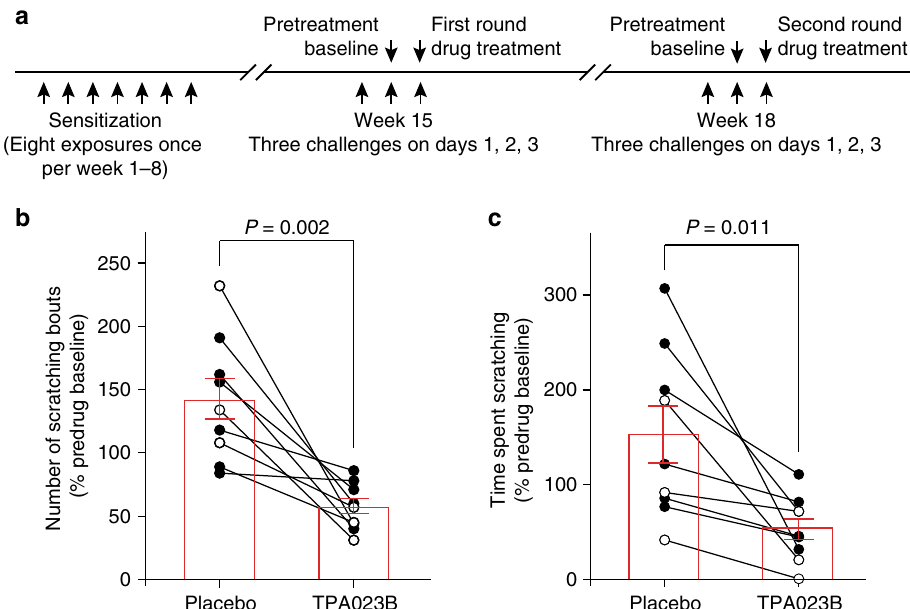
Fig. 10 Antipruritic actions of TPA023B in a dog model of allergic itch. a Time line of the study. TPA023B was administered as a tablet (20 mg, p.o.) and dogs ( n = 9) were monitored for 6 h starting immediately after drug/placebo administration. An additional round of three challenges (not displayed) was made on week 12. b , c Effect of TPA023B on the number of scratching bouts per hour ( b ) and time spent scratching in min hour − 1 ( c ). Both outcome parameters were normalized to the values obtained on the day before drug treatment. Dots and connecting lines represent values of individual dogs and changes in these values following treatment with TPA023B. Open and closed circles are dogs that received TPA023B either in round 1 or in round 2, respectively. P values were determined using paired two-sided t -tests. Error bars indicate RRID:AB_632234) and cyanine 3 (Cy3)-conjugated, Alexa Fluor 488-conjugated, DyLight 488-conjugated, 647-conjugated, and 649-conjugated donkey secondary antibodies (1:500; Dianova, Hamburg, Germany). Retrograde tracing experiments were done in 8 – 9-week-old mice. Image analysis . Fluorescent images were acquired on a Zeiss LSM710 Pascal confocal microscope using a 0.8 NA 20x Plan-apochromat objective or a 1.4 NA 63x EC Plan-Neo fl uar oil-immersion objective and the ZEN2012 software (Carl Zeiss). Whenever applicable, contrast, illumination, and false colors were adjusted in ImageJ or Adobe Photoshop (Adobe Systems, Dublin, Ireland). Cell numbers were quanti fi ed in a total of 9 sections prepared from 3 animals. In order to avoid double counting of cells in adjacent sections, all sections used for quanti fi cation were taken at a distance of at least 50µm. The numbers of immune reactive cells were determined using the ImageJ Cell Counter plug-in.